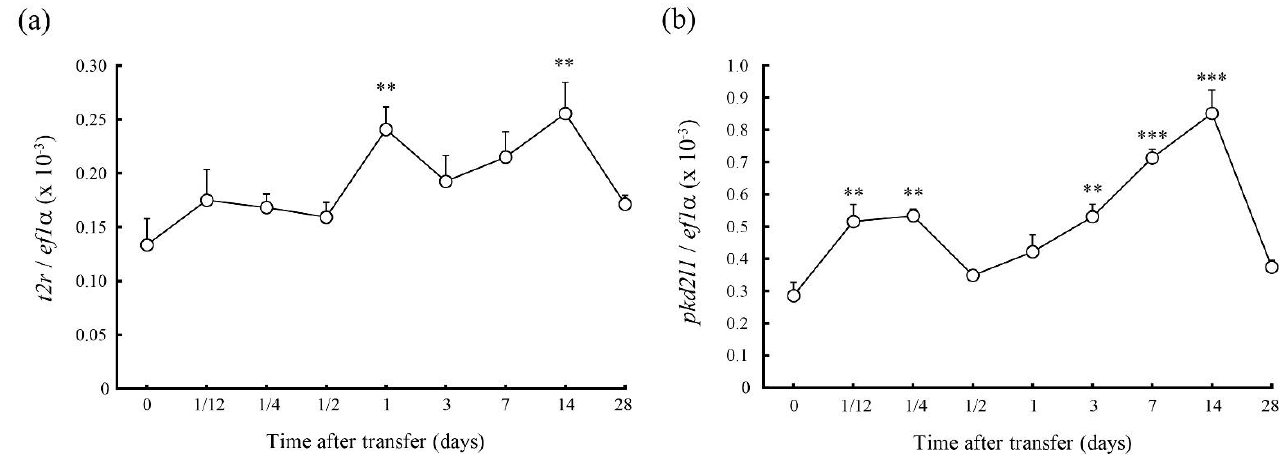
Figure 4. Changes in gene expressions of taste receptor type-2 ( t2r ) ( a ) and polycystic kidney disease 2-like 1 ( pkd2l1 ) ( b ) after transfer of FW-acclimated medakas to 70% SW. Values are means ± SEM (N = 6 – 7). Asterisks indicate significant differences between FW (0 h) and time points of SW challenge (Dunnett’s multiple-comparison test, ** p < 0.01 and *** p < 0.001).